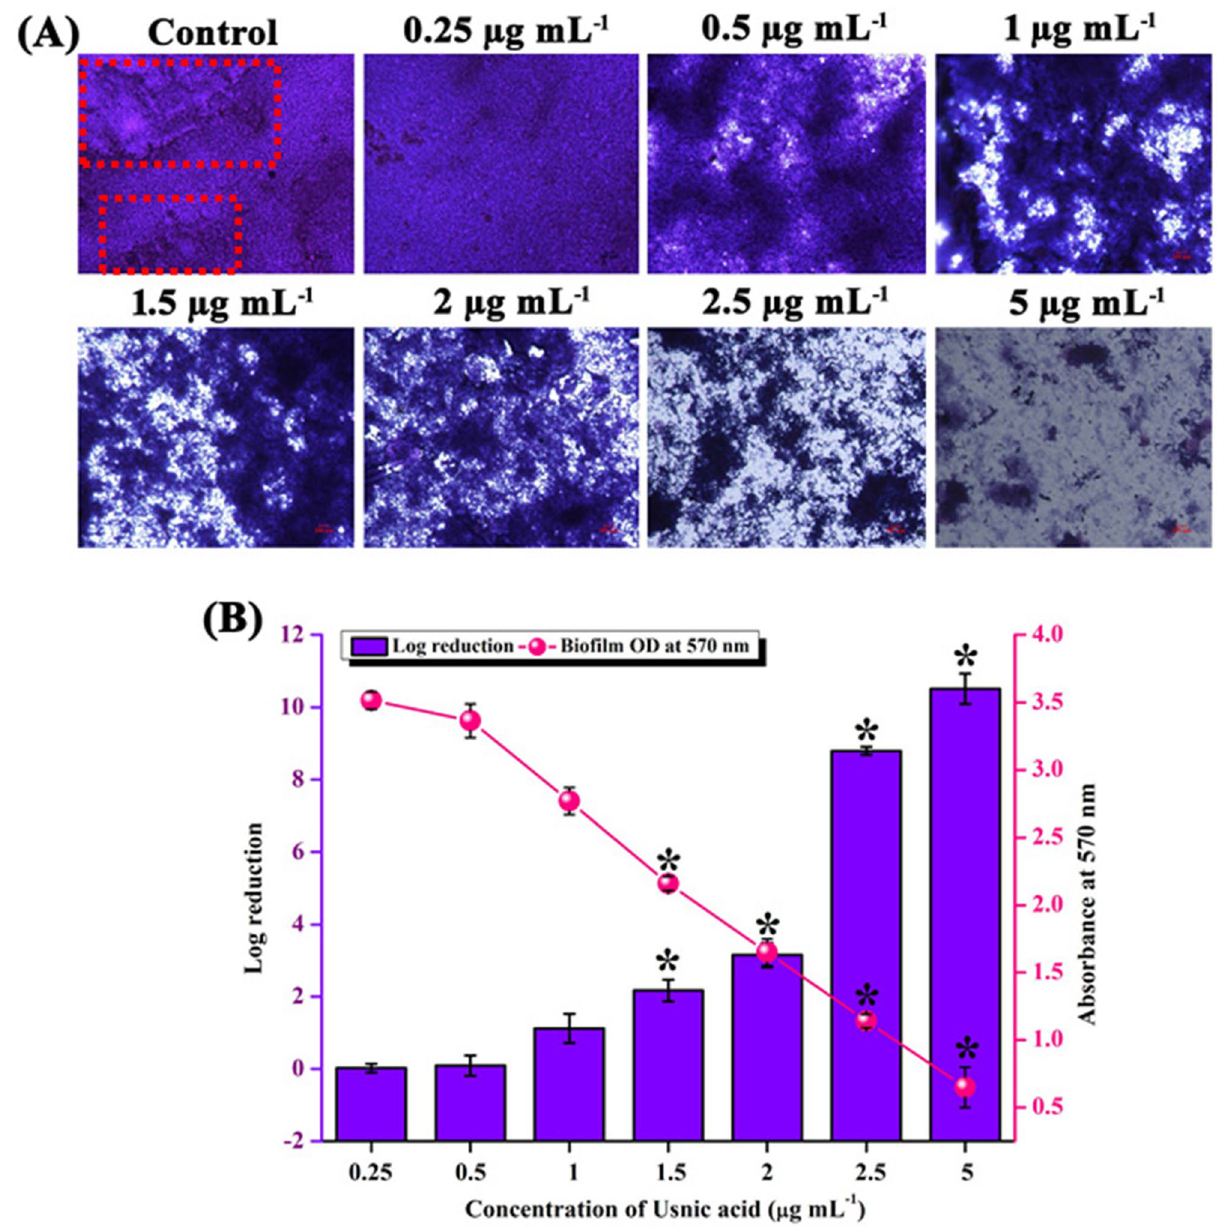
Figure 4. Effect of UA on biofilm formation. ( A ) Dose dependent reduction in the surface attached biofilm formation was observed. Multi-layered biofilm architecture (indicated in red coloured box) in the untreated S. mutans sessile life form was found to be absent in the sessile cells of UA treated S. mutans. Scale bar indicates 100 µm. ( B ) Biofilm biomass quantified through spectrophotometric method and cfu analysis displaying the concentration dependent reduction in the surface attached S. mutans cells under the influence of UA